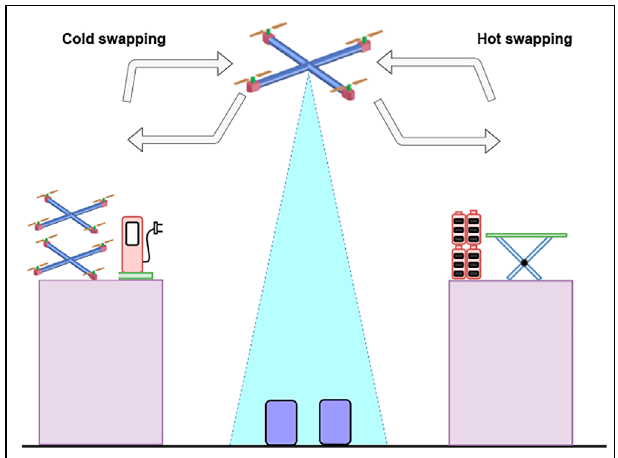
FIGURE 6 | Hot swapping vs. Cold Swapping (Galkin et al. (2019)).